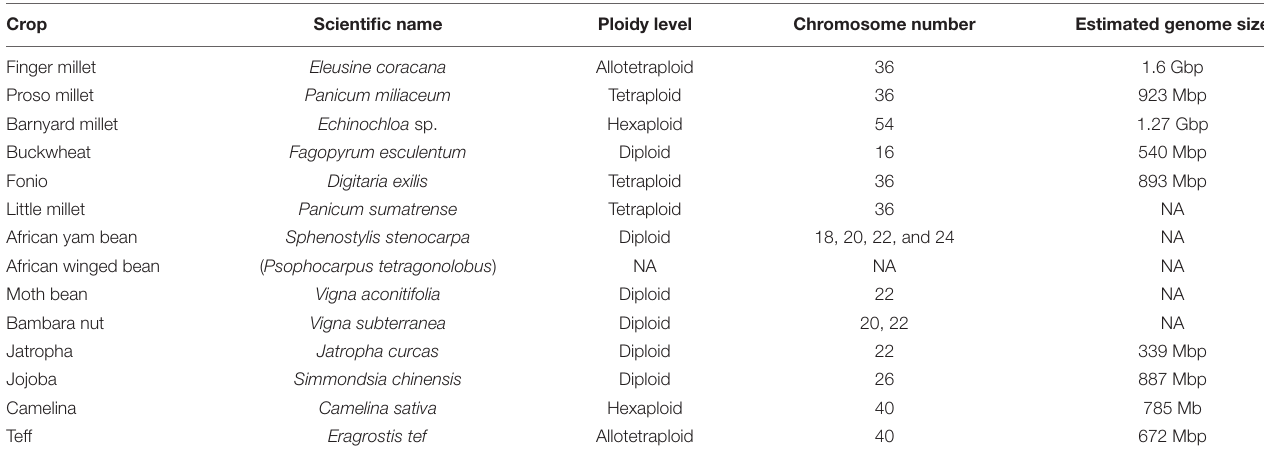
TABLE 4 | Cytogenetic and genome details of selected orphan